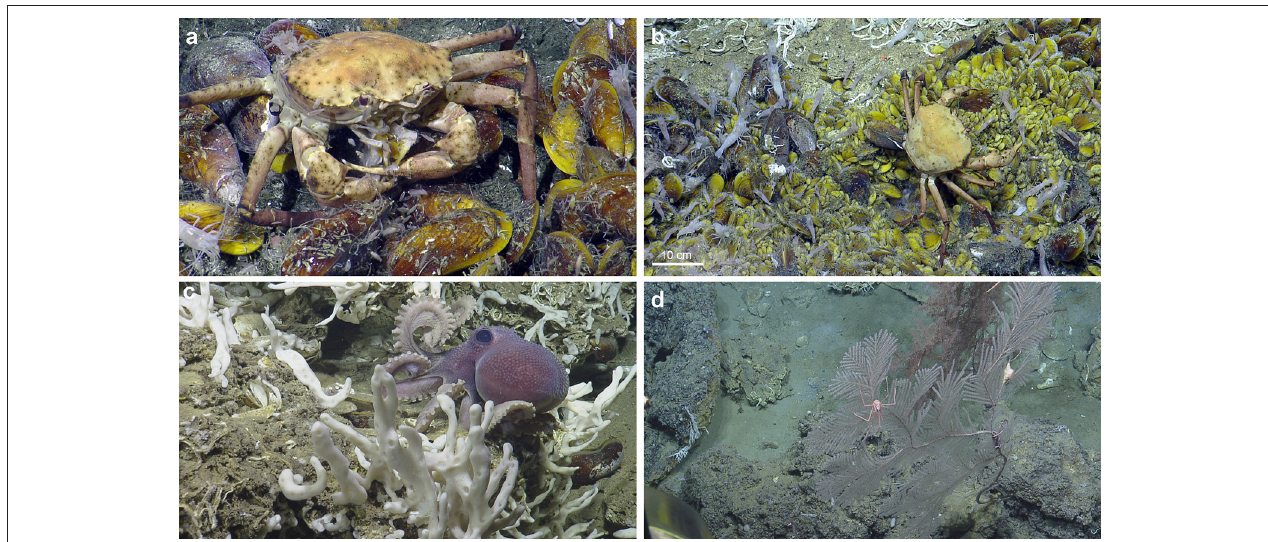
FIGURE 5 | Ecological observations at El Pilar. (a) Chaceon cf. fenneri and amphipods consume a Bathymodiolus childressi at “Dome 1.” (b) Variably sized Bathymodiolus childressi and Alvinocaris cf. muricola indicate ongoing recruitment at “Dome 1.” (c) A new species of Graneledone octopus seen by its